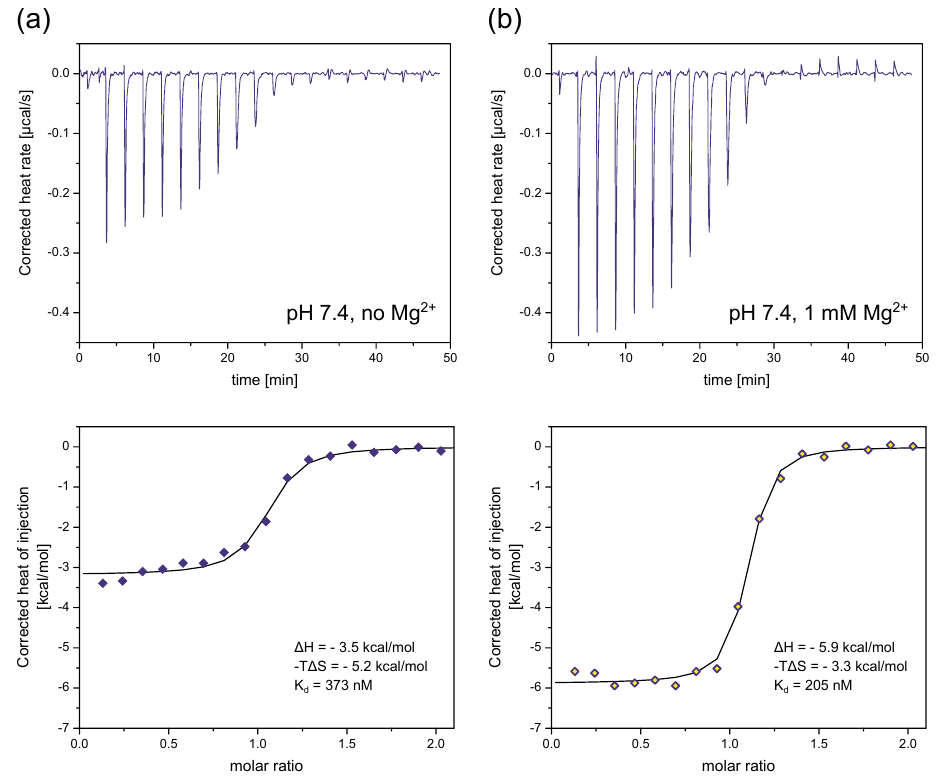
Figure 7. Isothermal titration calorimetry of ( a ) InsP 8 binding to the yeast VTC2 SPX–domain (50 µ M) in ITC binding buffer (25 mM HEPES pH 7.4, 150 mM KCl, 40 mM NaCl, 0.5 mM TCEP) at 25 ◦ C. ( b ) Addition of 1 mM MgCl 2 substantially decreases ∆ H, ∆ S and the binding constant K d . The figure shows one representative replicate per condition, out of three replicates (Figure S9). ∆ H, ∆ S and K d are reported as the average of three